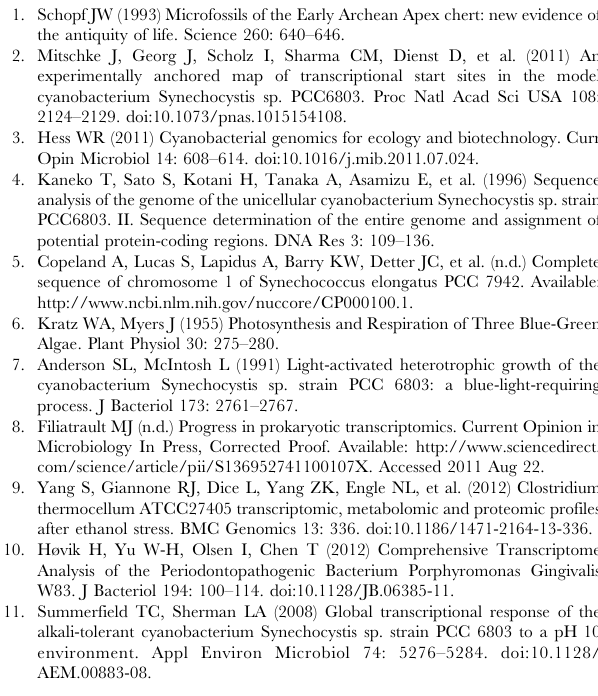
Table S2 RPKM levels for genes of both organisms for all conditions. Scale: RPKM*10 ‘ 9. (XLSX) Table S3 Results obtained by using 5 9 enriched data for Synechococcus . Individual worksheets list CDS with 5 9 peak downstream of their annotated translation initiation sequence, CDSs without any detectable 5 9 peak and Transcriptional Units with more than one CDS (operons). (XLS) Table S4 CDS that could be functionally related using unsupervised clustering based on the assumption that genes with similar expression profiles are functionally linked. (XLSX) Table S5 Subset of Supplementary Table S2. Gene expression data for genes associated with pathways referenced in the manuscript. (XLSX) File S1 Sequence similarity results based on blast for newly identified transcribed sequences located in inter- genic regions.